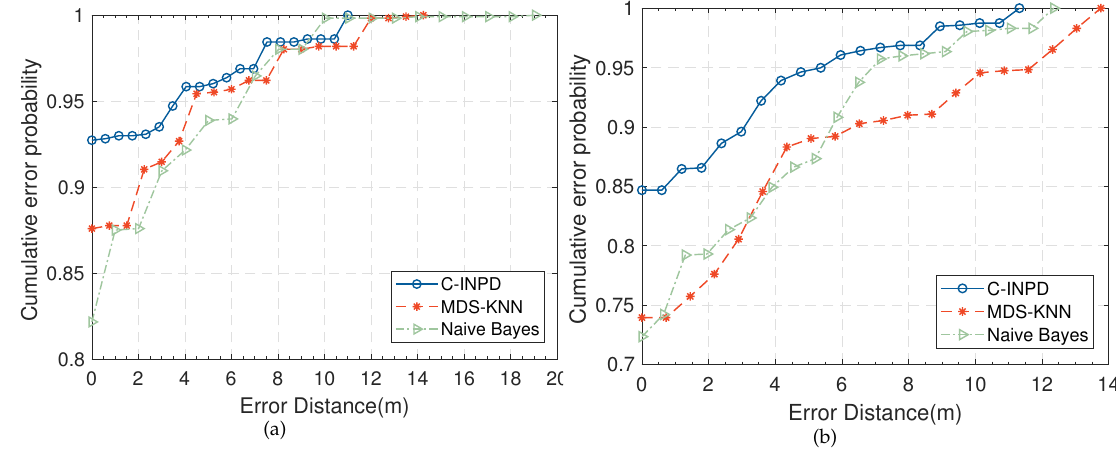
Figure 20. The performance comparision of different positioning systems. ( a ) The CDF comparison among C-InP, MDS-KNN and NB in the integrated room. ( b ) The CDF comparison among C-InP, MDS-KNN and NB in the